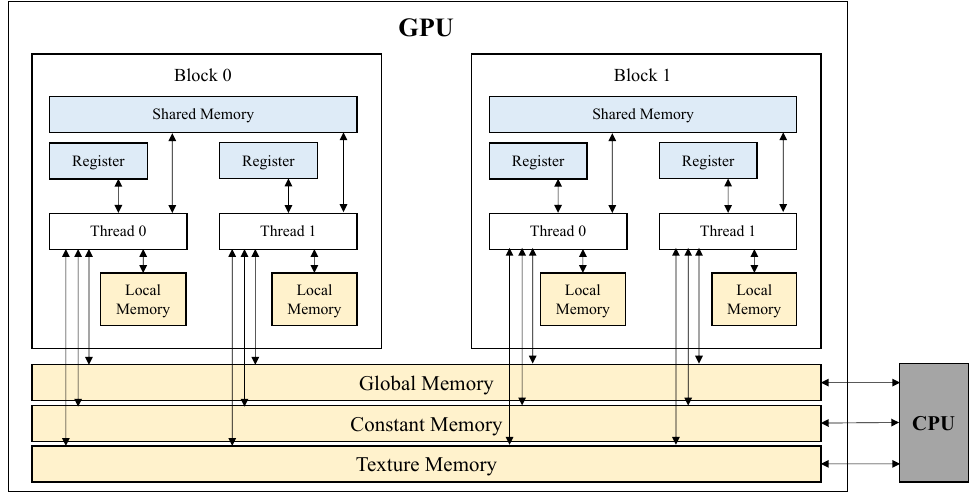
Figure 2. Structure of GPU